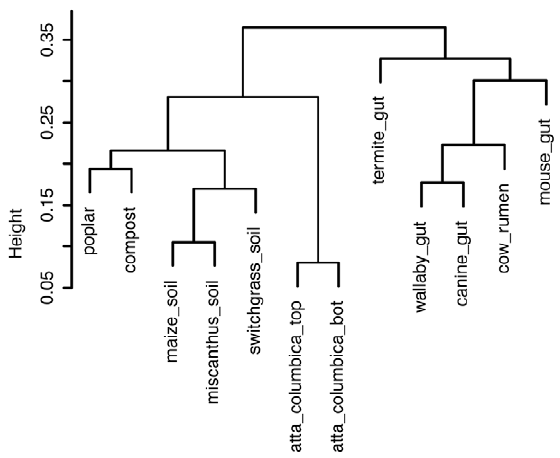
Figure 6. Calculated correlation distances between the meta- genomes of the microbiomes associated with the poplar biomass decay community, compost, rhizosphere soils from maize, miscanthus and switchgrass, the top and bottom part of the fungal garden of the leaf-cutter ant ( Attacolombica ), cow rumen, and the gut communities from termite, wallaby, canine, human and mouse. The distribution and relative abundance of glycoside hydrolase families was used as variables for metagenome comparison on the level of functionality related to biomass breakdown. This information was obtained for the various metagenome sequence sets by performing Blastx against the CAZy database, and was subsequently used to calculate the correlation distances between the various metagenomes.